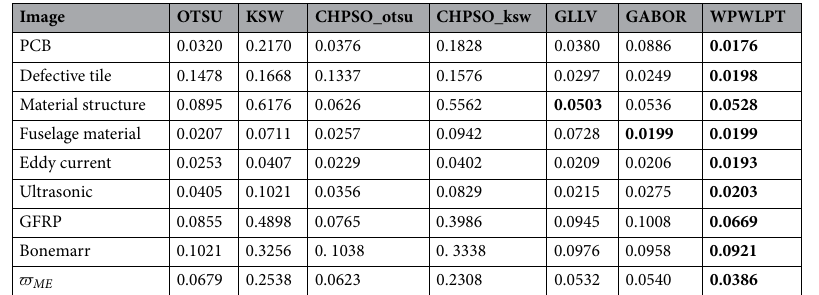
Table 3. MEs of the different thresholding methods. The best results are highlighted in bold.